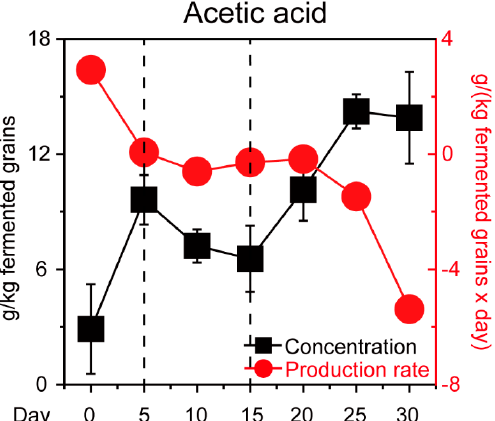
Figure 2. Dynamic concentration and production rate of acetic acid during Baijiu production. Data are expressed as mean ± SD from biological triplicates. Error bars indicate standard deviation from three independent sampling points.